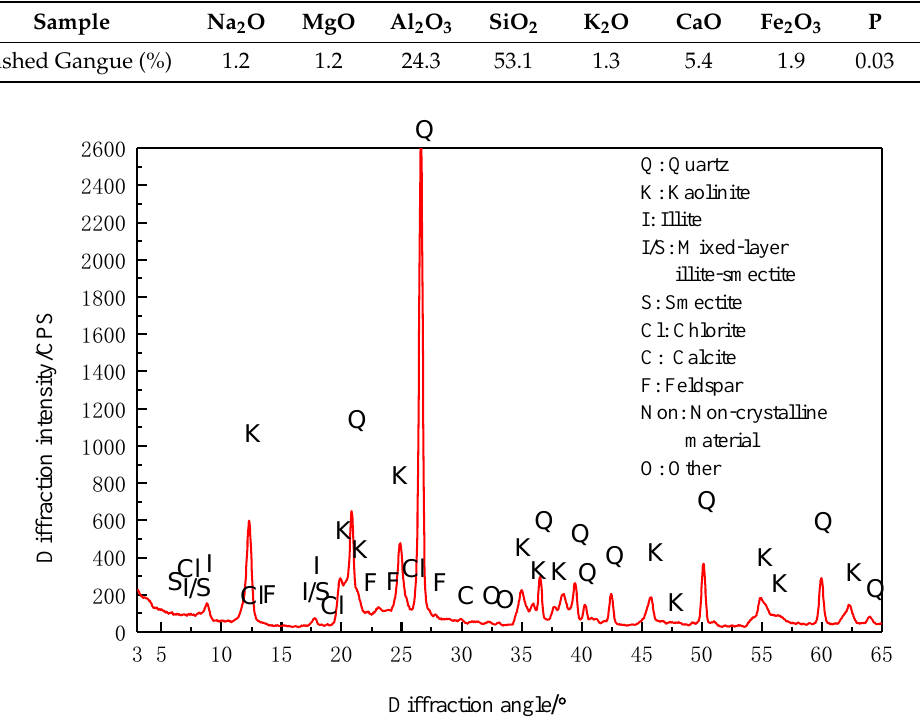
Table 1. Chemical composition of washed gangue.